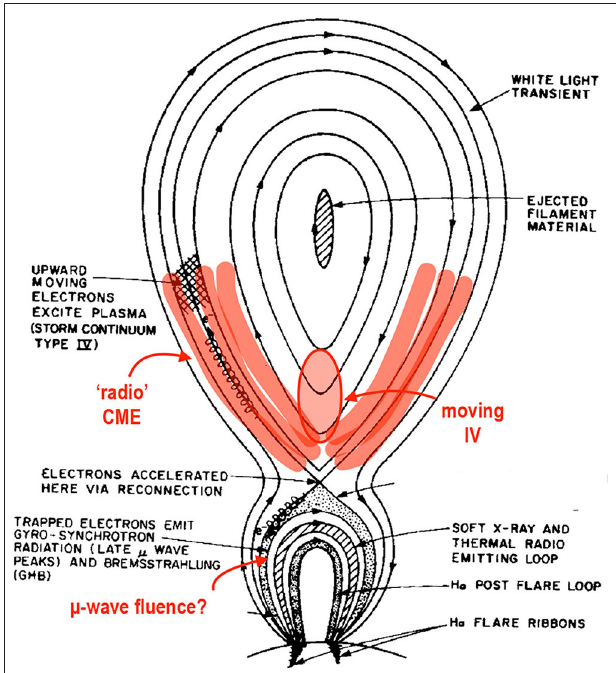
FIGURE 3 | A cartoon representing the flare-CME model from Cliver et al. (1986) showing the origin of various radio emissions. We mark areas impacted by the newer observations. Reproduced by permission of the